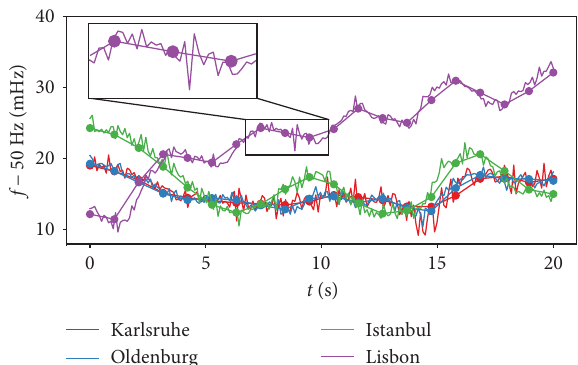
Figure 1: Snippets of power-grid frequency trajectories. Power-grid frequency trajectories from 2019-07-27 06:00 in Continental Europe, for 20seconds, including 1-second resolution and 100ms resolution data. Te smaller 100ms resolution recordings fuctuate strongly around the 1s resolution data, sometimes with very large jumps. Te frequency dynamics are revealed as fractal for this exemplary trajectory: if we “zoom in” to higher temporal resolutions, we observe that the data is self-afne, i.e., the data displays self-similarity in its fuctuations. In the inset, we focus on a 2-second span, where we can observe both small fuctuations (in the 1st second) and large fuctuations (in the 2nd